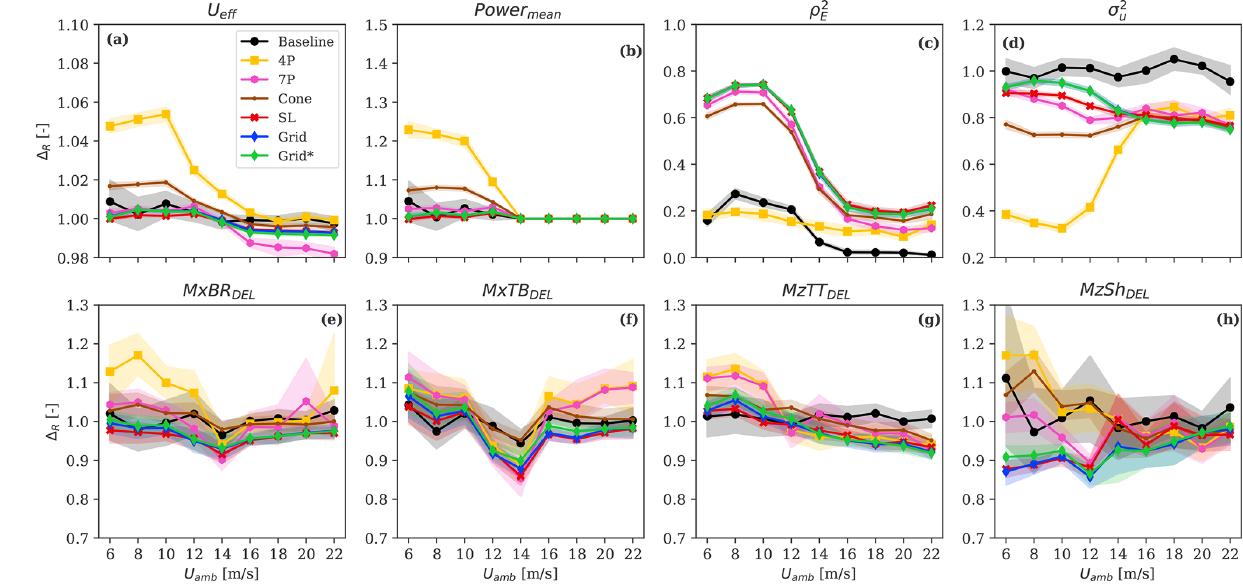
Figure 11. Comparison of bias (cid:49) R (solid line) and uncertainty X R (error band) in selected load sensors as a function of the ambient wind speed. The uncertainty indicators are computed against the target observations for each ambient wind speed (marker) that consists in 18 aeroelastic simulations with random turbulence field realizations. The lidar-based results are derived from simulations with WDS fields.